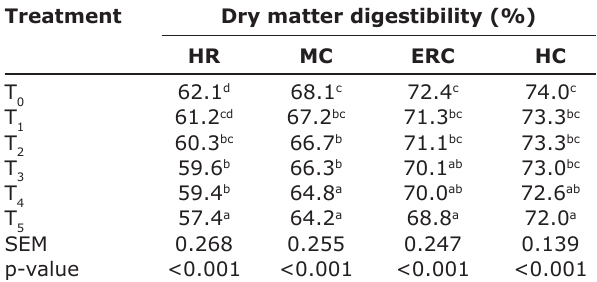
Table-6: Effect of graded levels of silkworm pupae oil supplementation with different dietary regimes on in vitro dry matter digestibility (%).